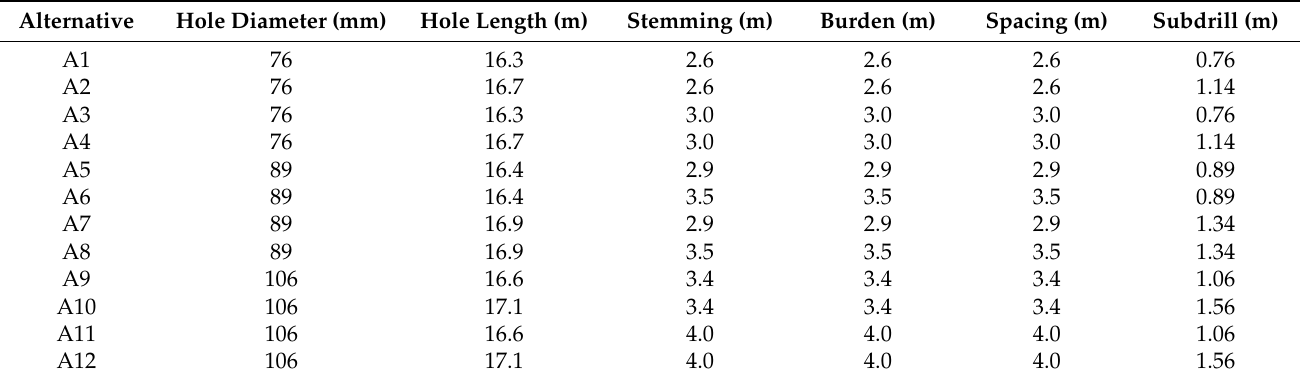
Table 2. Parameters of blasting patterns.